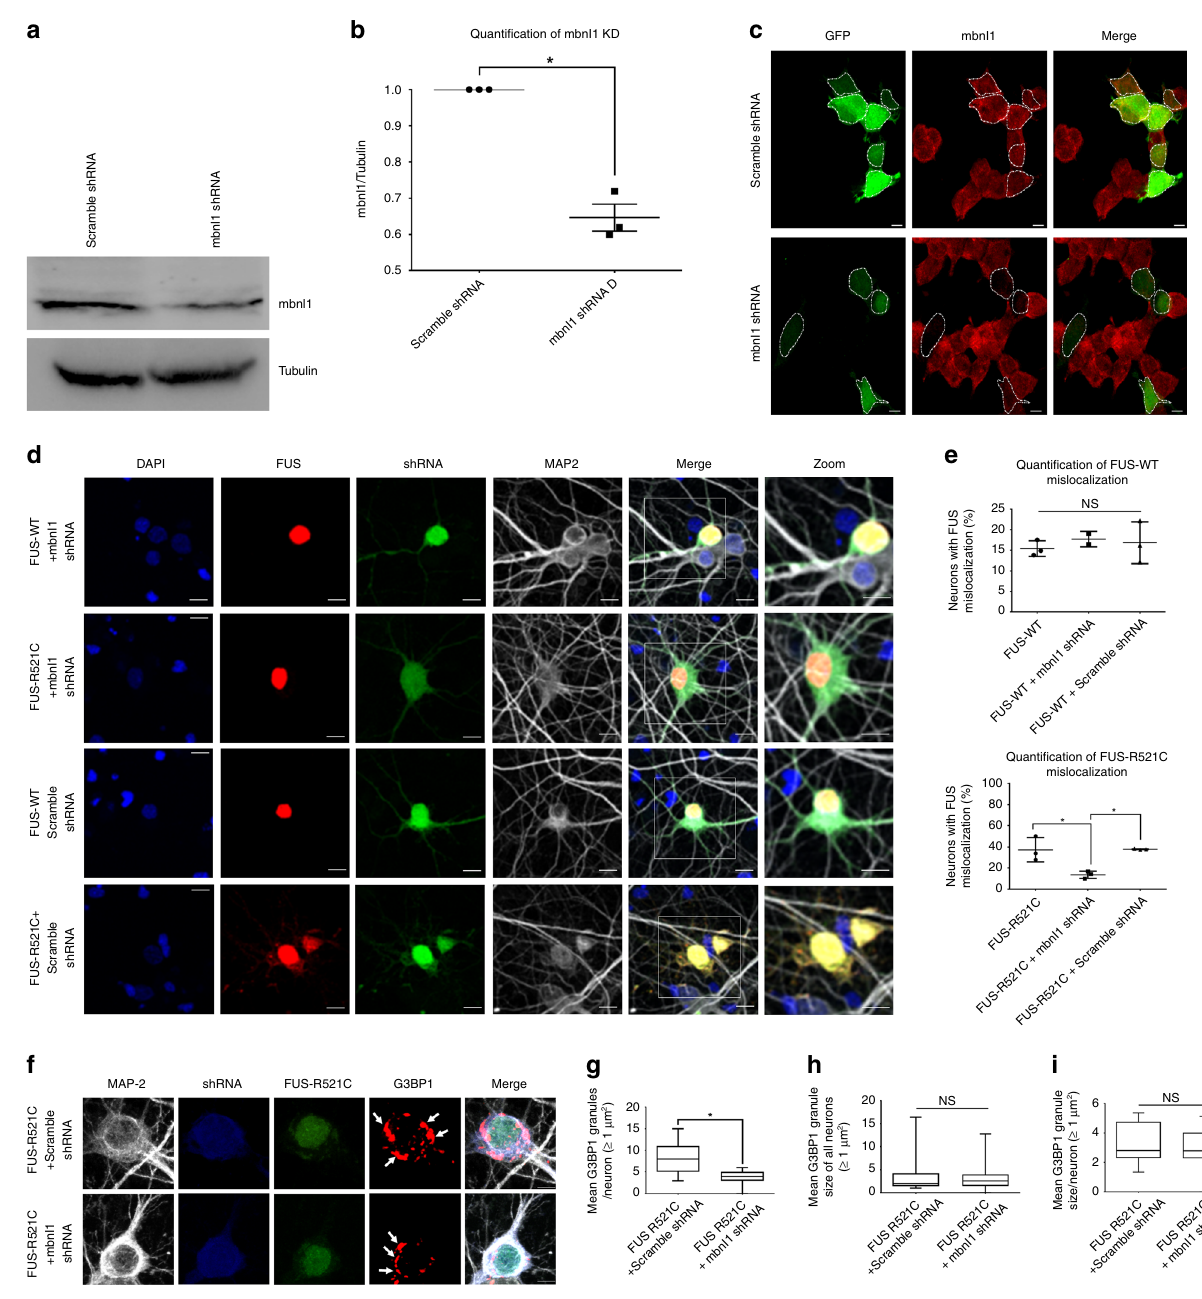
Fig. 4 Mbnl1 KD rescues mutant FUS mislocalization in primary cortical neurons. Rat primary cortical neurons (PC12 cells) were co-transfected with FUS (either wild-type or R521C) and either M bnl1 -speci fi c or scrambled shRNA. FUS-positive cells were analyzed for cellular distribution of exogenous FUS and SG formation. a – c Validation of mbnl1 knockdown in PC12 cells. a Representative WB of PC12 cells transiently transfected with either scramble or mbnl1 - speci fi c shRNA. b Quanti fi cation of mbnl1 knockdown in PC12 cells ( N = 3). c mbnl1 immuno fl uorescence (red) in scrambled and mbnl1 shRNA-transfected PC12 cells (green). d Representative confocal images showing differences in wild-type and mutant FUS distributions in cortical neurons. Similar to cells transfected with FUS alone (Supplementary Fig. 13c), cells expressing scrambled shRNA showed wild-type and ALS-linked mutant FUS distributed in the nucleus and cytoplasm, respectively. However, in cells expressing mbnl1 -speci fi c shRNA, mutant FUS localizes primarily in the nucleus. White boxes indicate the magni fi ed areas shown in the fi nal column that highlight mislocalization of mutant FUS in scrambled shRNA-treated cells. e Quanti fi cation of the percentage of neurons with FUS mislocalization in each group, including the controls shown in Supplementary Fig. 13c. The results indicate signi fi cant rescue of mutant FUS-R521C mislocalization in cells co-transfected with mbnl1 shRNA compared with the scramble shRNA control group ( N > 30 cells/ group). f Representative fl uorescent images of sodium arsenite induced SGs in cortical neurons expressing mutant FUS and either mbnl1 or scrambled shRNA. MAP2 and G3BP1 are markers of neurons and SGs, respectively. Cells expressing mbnl1 shRNA show fewer cytoplasmic SGs compared with the scrambled shRNA group. g – i Quanti fi cation of the number and size of SGs in each group. Only SGs ≥ 1 µ m 2 were used. N > 15 cells/group. g The average number of G3BP1-positive SGs/neuron is signi fi cantly lower in mbnl1 shRNA-expressing cells than in scrambled shRNA control cells. No differences in the average size of FUS-positive SGs occur between shRNA groups h across all transfected neurons or i averaged per neuron. One-way ANOVA with Tukey ’ s multiple comparisons test was used in e (* P = 0.008, NS = not signi fi cant). Two-tailed t tests were used for comparisons in g – i (* P = 0.0028, NS).